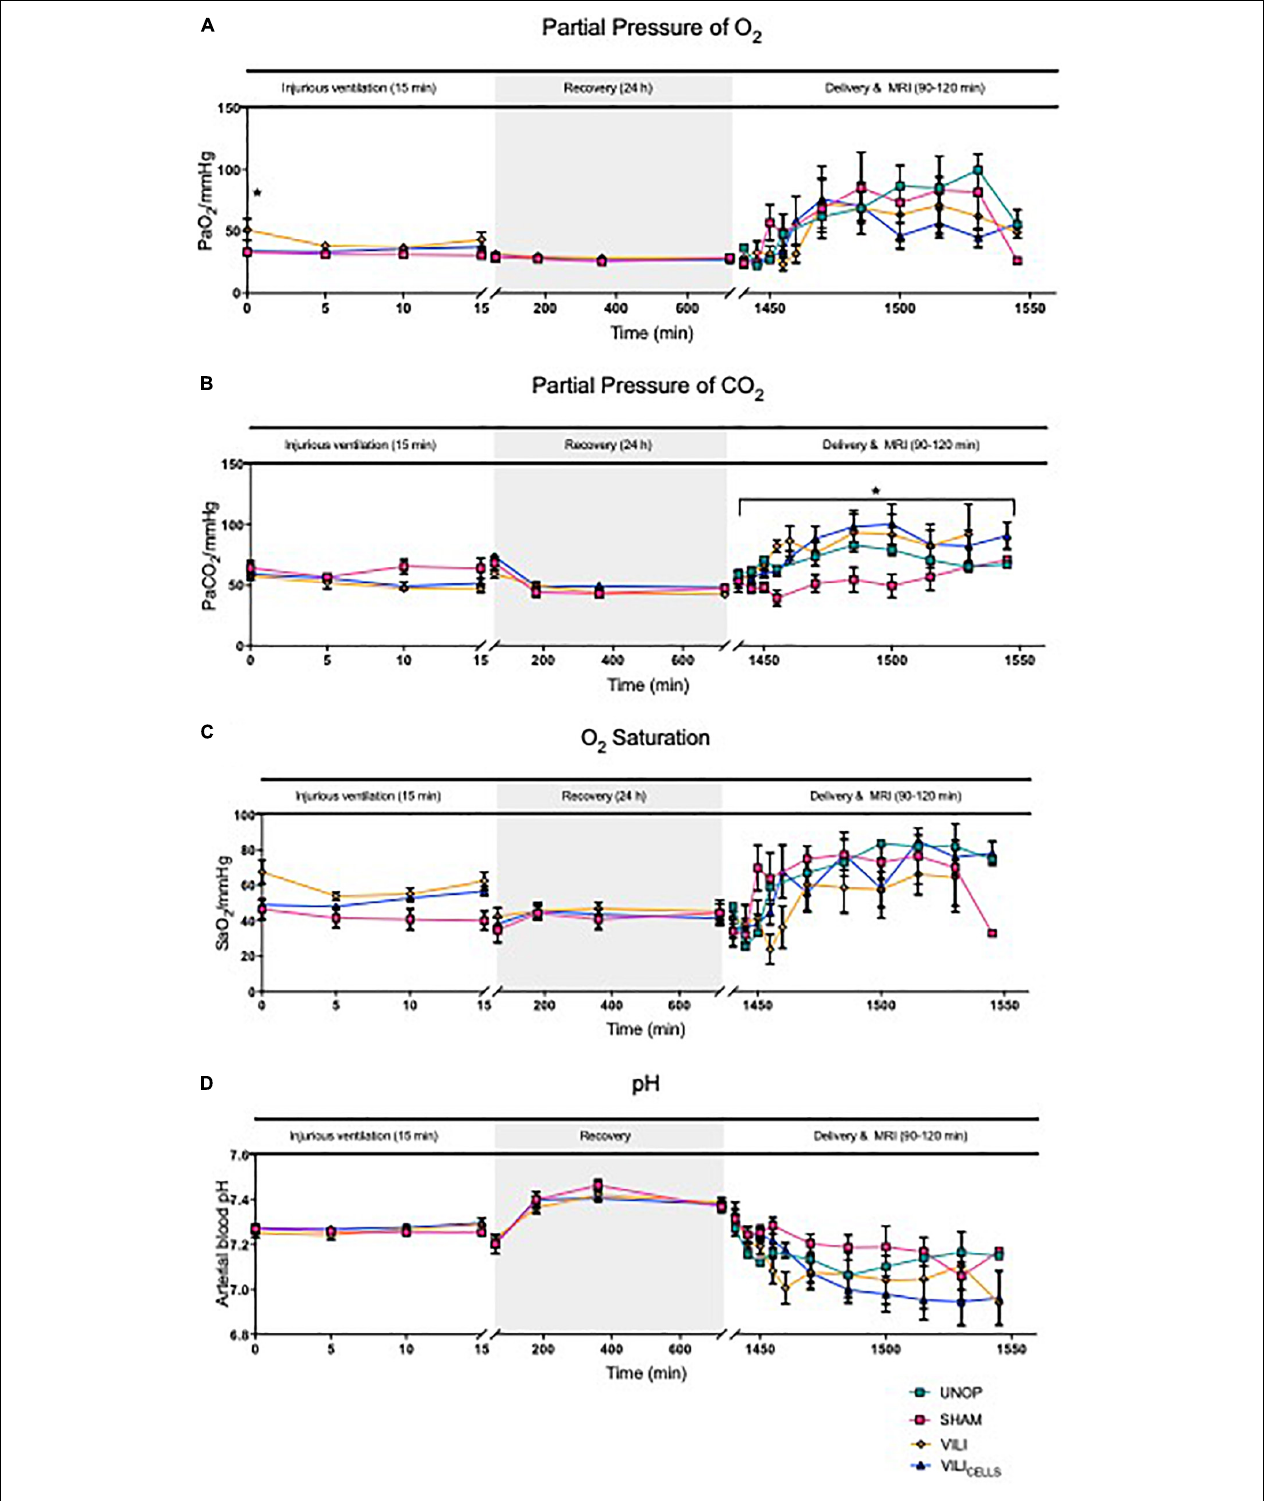
FIGURE 2 | Blood gas parameters between SHAM, VILI, and VILI CELLS for the injurious ventilation period and recovery period and between UNOP, SHAM, VILI, and VILI CELLS for delivery and MRI; partial pressure of (A) O 2 , (B) CO 2 , (C) saturation of oxygen, and (D) pH. Asterisk in panel (A) indicates significant difference in PaO 2 at time 0 between VILI and SHAM groups. Asterisk in panel (B) indicates difference in PaCO 2 during delivery and MRI, with SHAM significantly lower than VILI and VILI CELLS groups, * P <